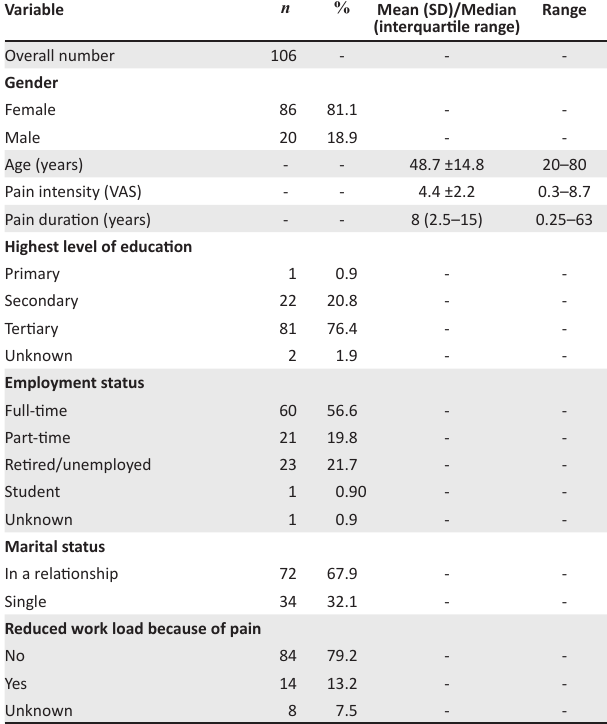
TABLE 1: The demographic profile of the participants ( n =